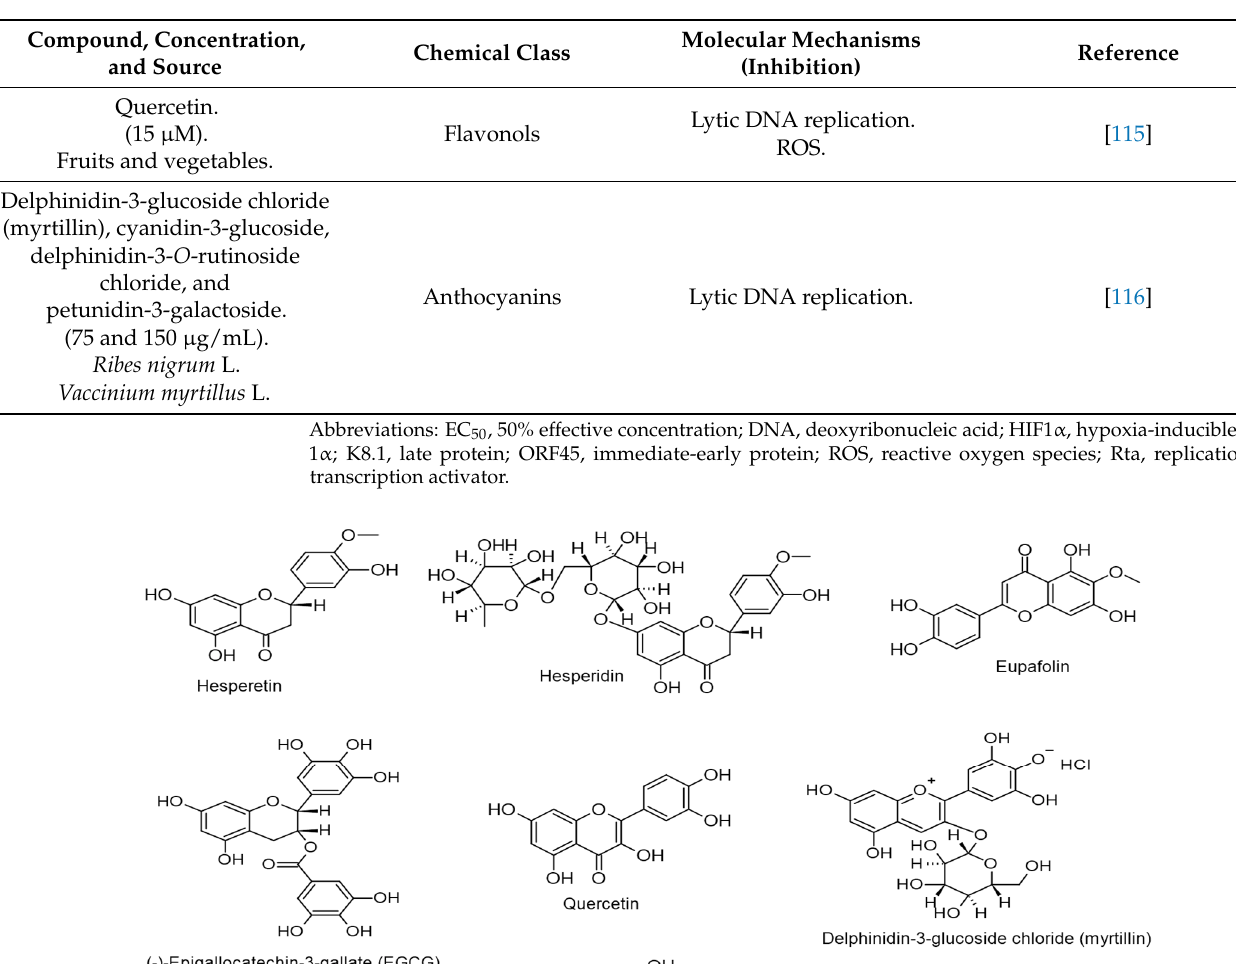
Figure 11. Chemical structures of flavones with therapeutic effects against KSHV-associated malignancies. 4.2.2. Flavonols At a concentration of 50 µM, quercetin (Figure 12) in vitro was observed to interfere with multiple cancer-related pathways, inducing apoptosis and autophagy in KSHV- positive PEL cells. It repressed PI3K/AKT/mTOR and STAT3 signaling pathways and